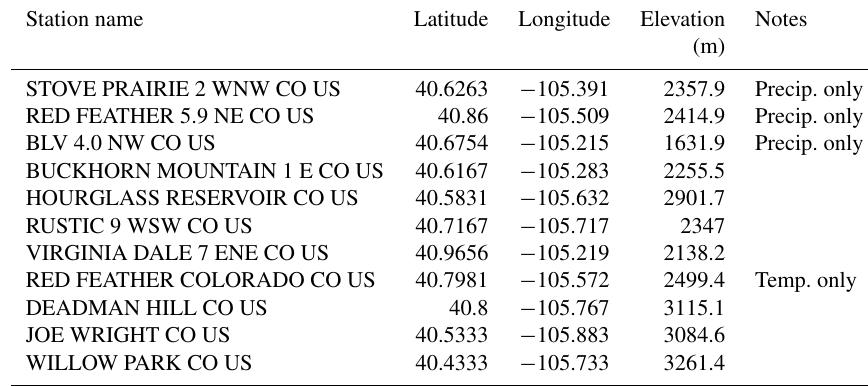
Table A2. Meteorological stations used for this study. Station